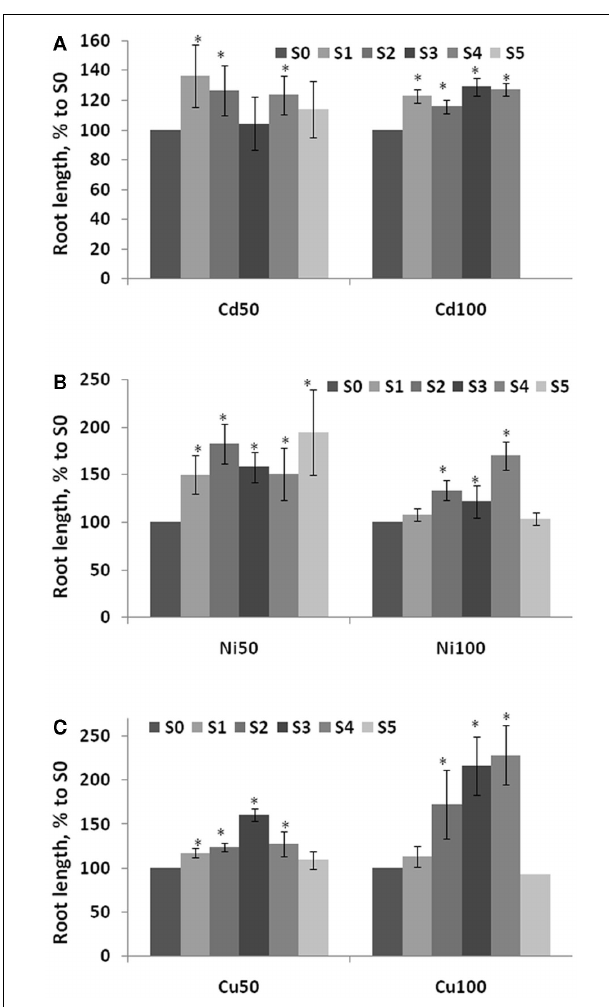
FIGURE 4 | Root length in the progeny of stressed plants. Root length was measured in five consecutive generations of plants exposed to 50 and 100mM Cd 2 + (A) , 50 and 100mM Ni 2 + (B) , and 50 and 100mM Cu 2 + (C) as well as non-exposed plants. Plants were germinated and grown on normal MS medium and roots were measured at 2weeks post-germination.The vertical axis indicates the average (with SD, calculated from three different experiments) root length in S1–S5 plants shown as percentage difference to the root length in S0 plants. Asterisks show when there is a significant difference between the individual groups of S1–S5 plants and S0 plants (Student’s t -test, p < 0.05 in each